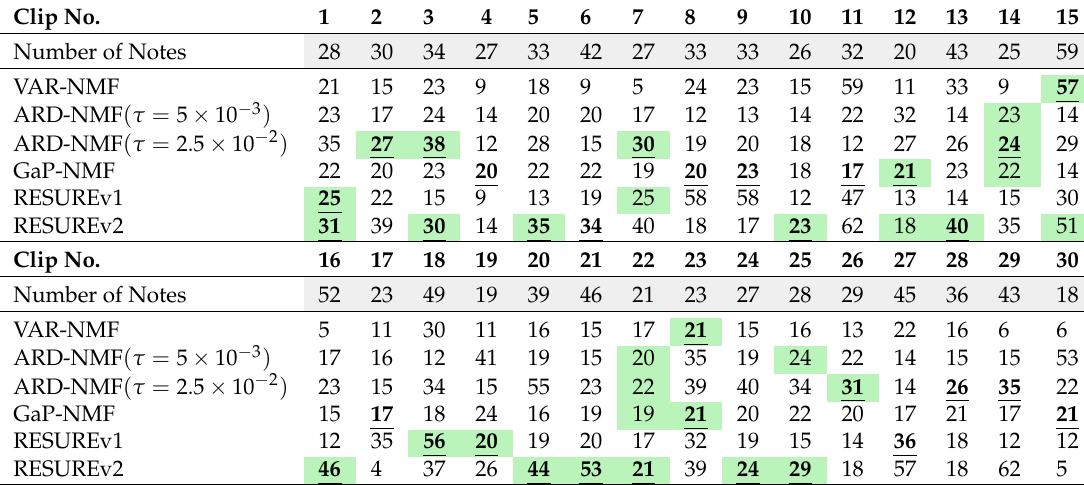
Table 1. Estimated NMF ranks for 30 test signals. The underlined bold number indicates the result closest to the number of musical notes for each clip, and the (highlighted) green value indicates a result with an error within ± 15% of the number of musical